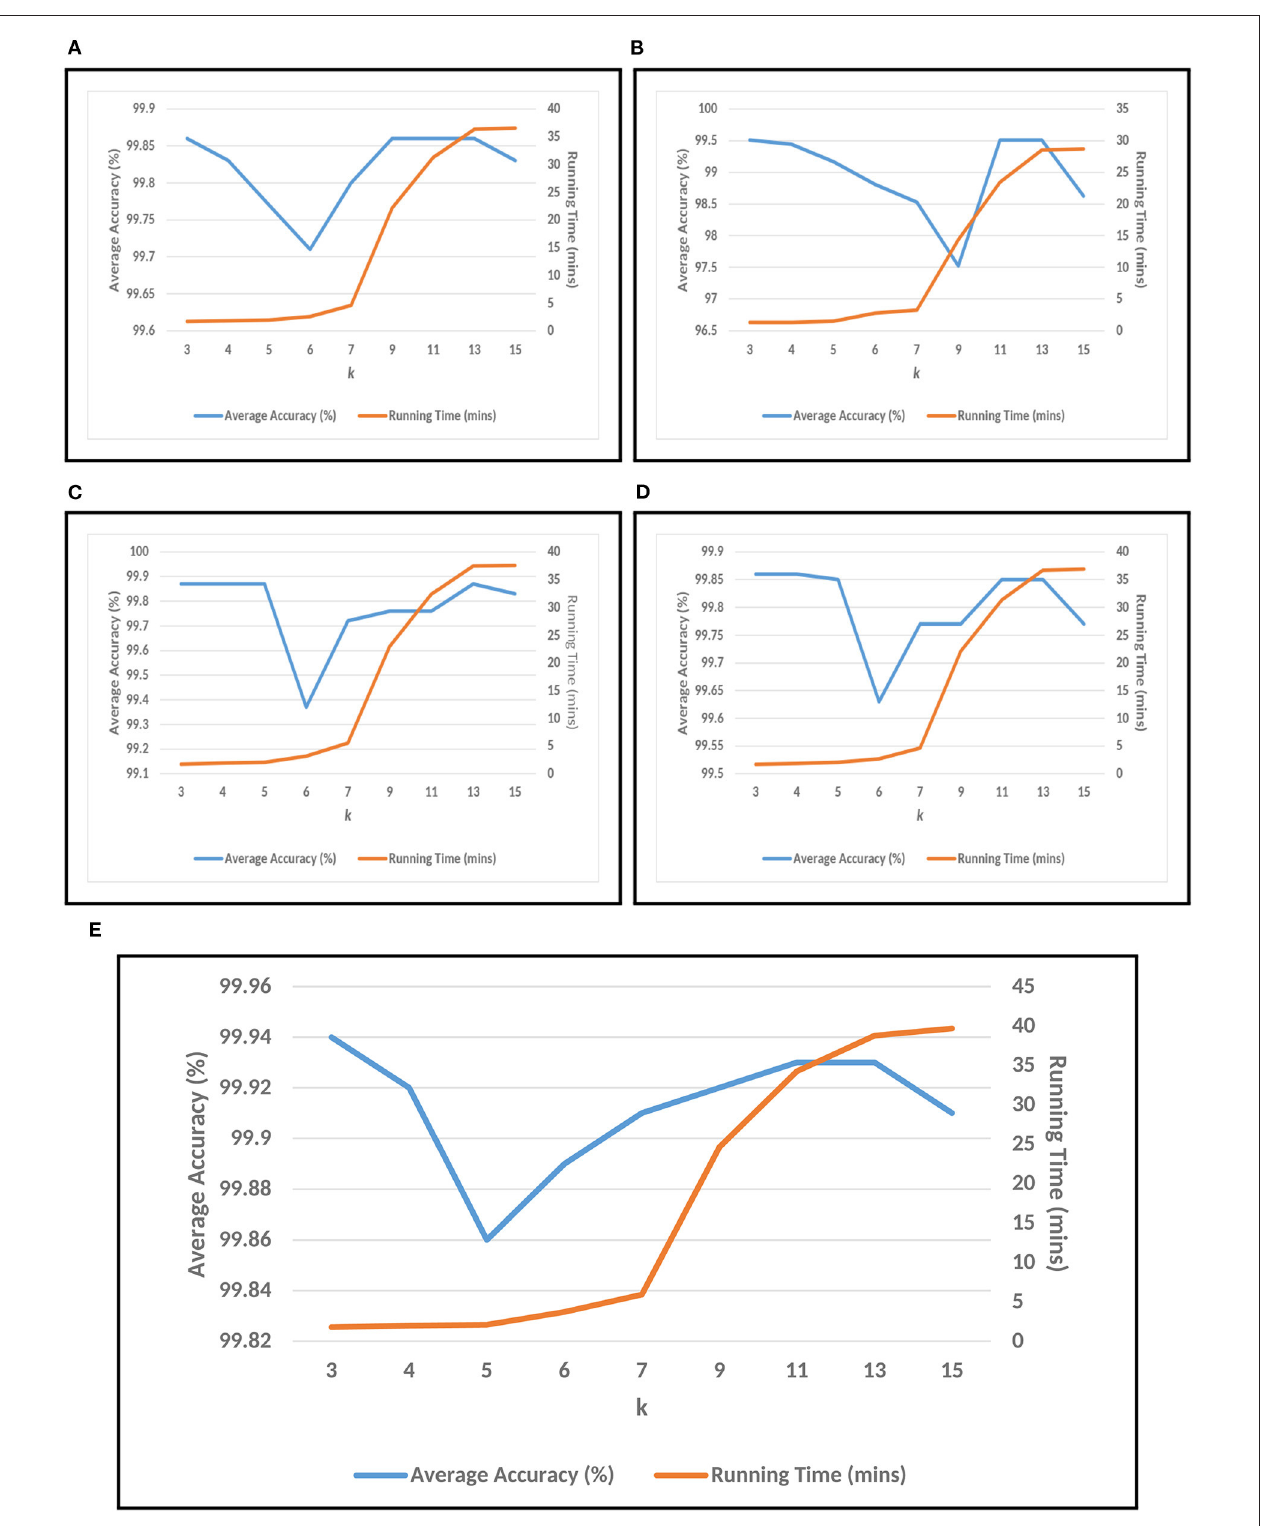
FIGURE 3 | Choosing k value of k -mer for COVID-DeepPredictor based on accuracy and running time. (A) Testdata-1, (B) Testdata-2, (C) Testdata-3, (D) Testdata-4, (E) Testdata-5.